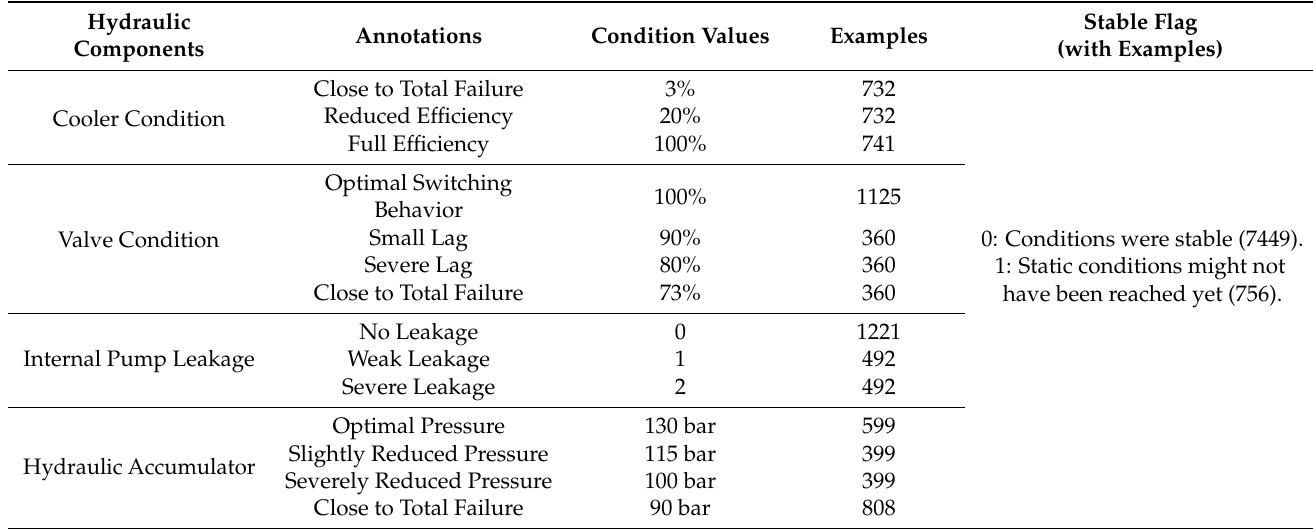
Table 1. Condition hydraulic components and stable flag expression in the hydraulic